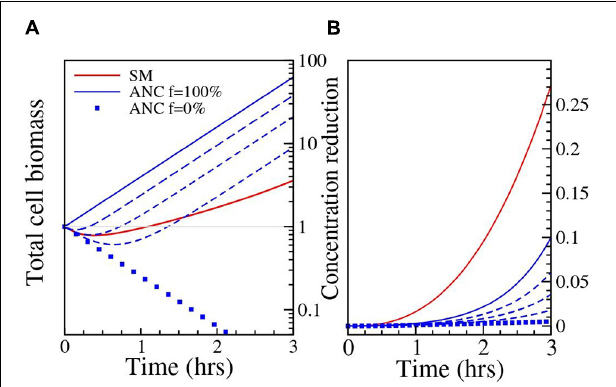
FIGURE 3 | Results of the numerical simulation. Parameters: Ancestor (ANC) σ E = 16 h − 1 ; σ B = 9 . 2 h − 1 ; Single mutant (SM) σ E = 2 . 81 h − 1 ; σ B = 1 h − 1 . Filamentation has been quantified through a normalized filamentation rate f (see Supplementary Material 4 ); the used values of f are 0% (filled squares), 25%, 50%, 75% (dashed lines) and 100% (solid line). (A) The change in biomass (in units of single cell size) is shown as a function of time. The blue lines correspond to the Ancestor and show the increasing effect of filamentation on cell biomass growth. For the Single mutant and the Ancestor at f = 25%, the cells die initially and then grow again as the antibiotic concentration is reduced through breakdown. (B) The reduction in antibiotic concentration relative to the initial value is shown as a function of